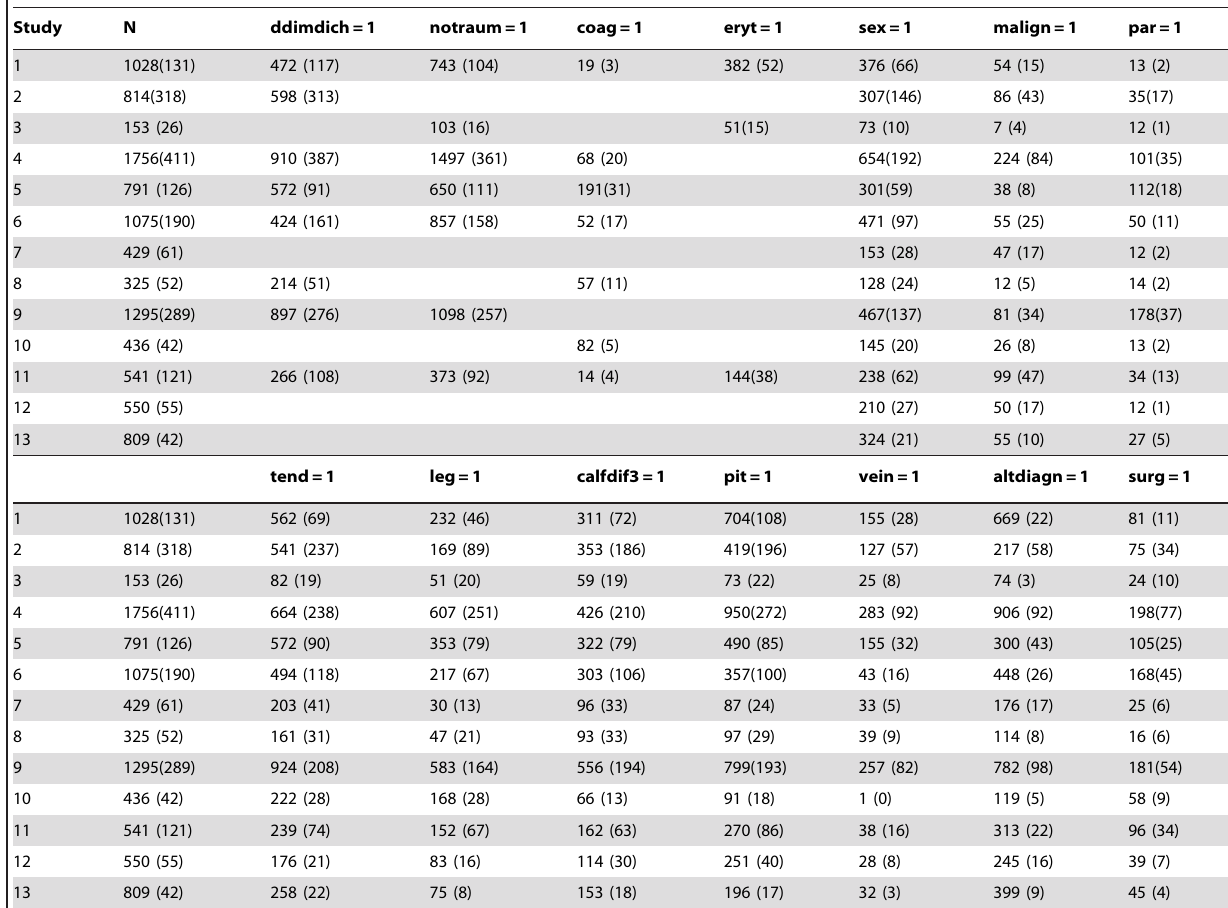
Table 1. Overview of the DVT